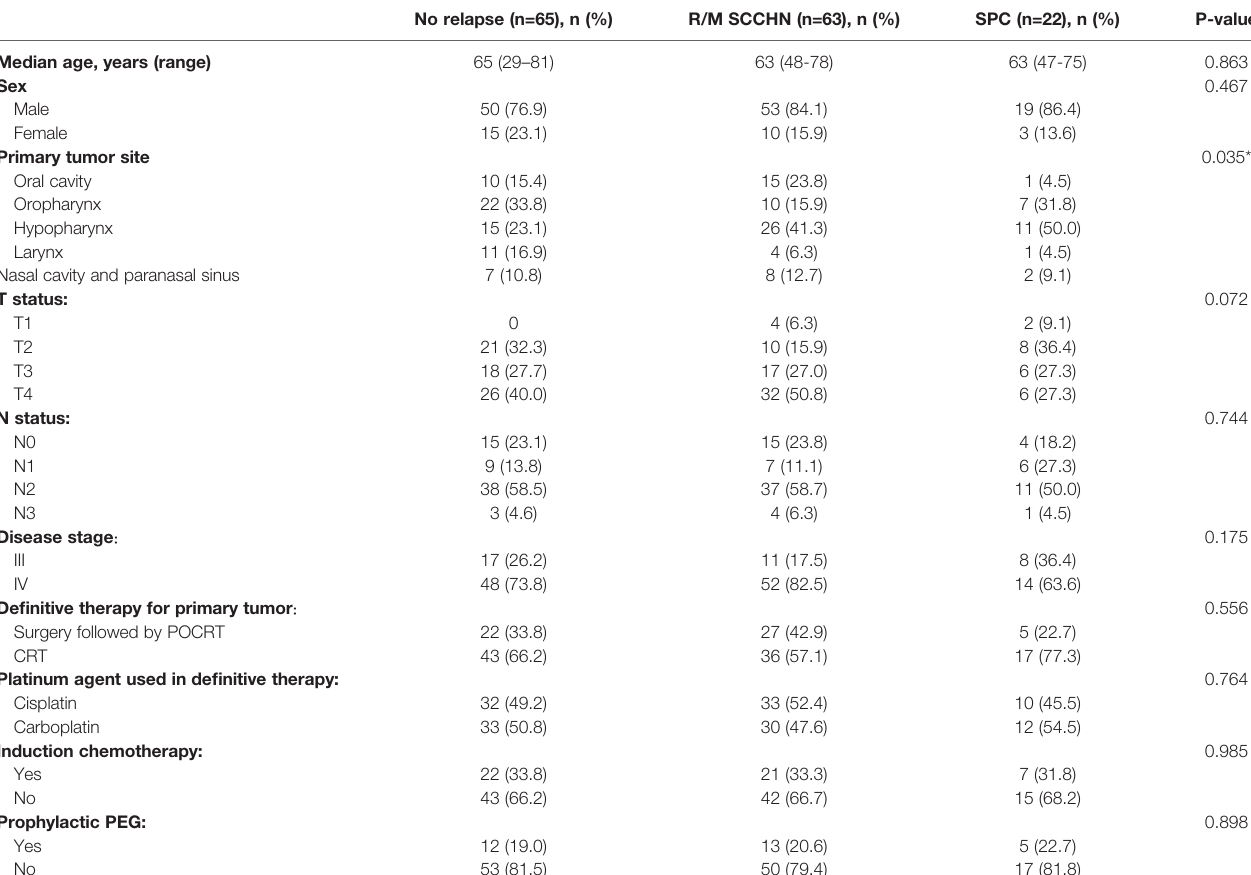
TABLE 1 | Characteristics at platinum-containing de fi nitive therapy. No relapse (n=65), n (%) R/M SCCHN (n=63), n (%) SPC (n=22), n (%) P-value Median age, years (range)